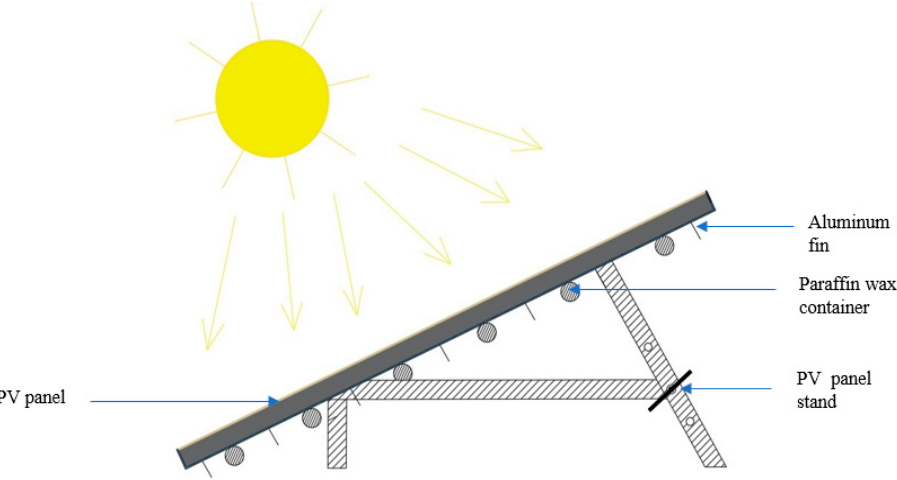
Figure 3. Schematic diagram of the experimental set-up.